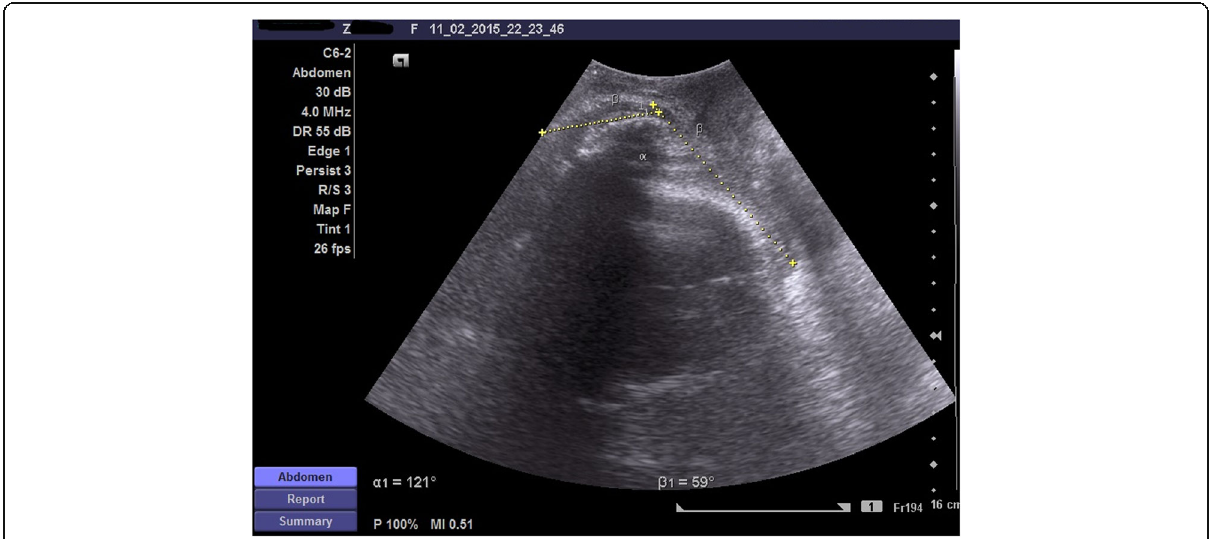
Fig. 1 TPUS showing angle of fetal head progression ( α ) reaching 121°. Two lines are drawn; one is placed through the midline of the symphysis pubis, and the other line is running through the caudal apex of the symphysis pubis to the fetal skull tangentially